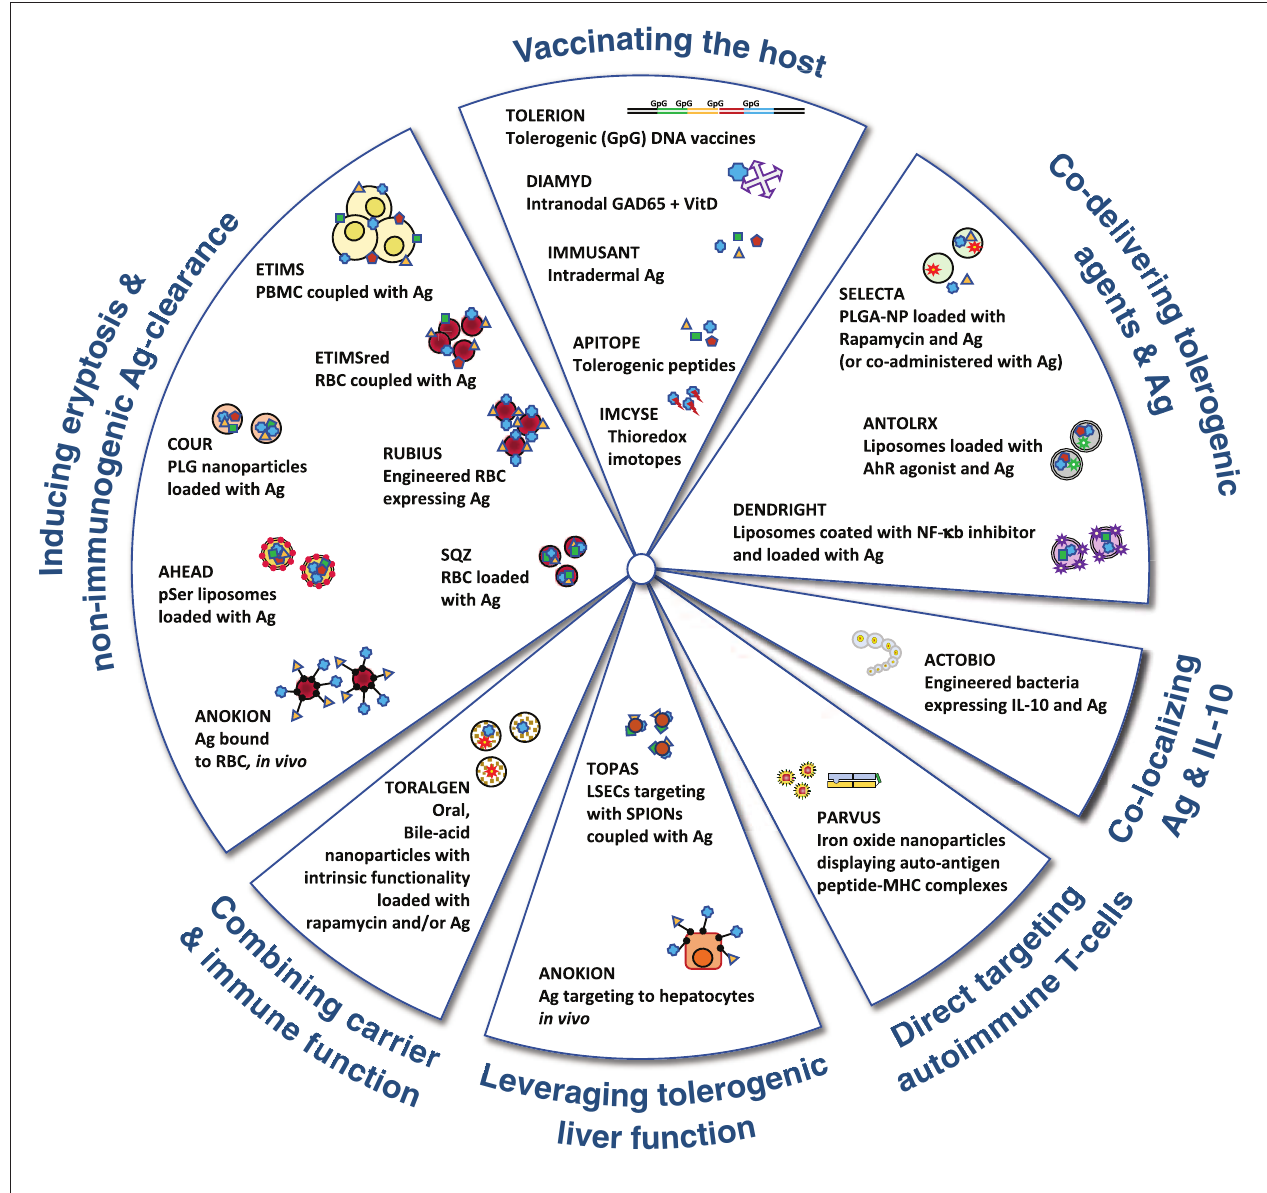
FIGURE 3 | Graphical representation of the major approaches being followed by pharma and biotech companies to induce immune tolerance. Antigen (Ag) could be one or more whole proteins or derived peptides involved in the autoimmune response. Further explanation on the different MoA is presented in the text.